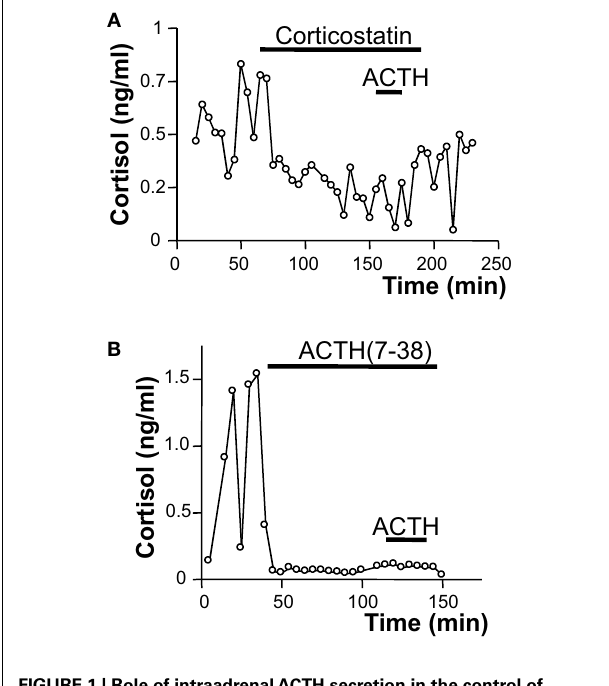
FIGURE 1 | Role of intraadrenalACTH secretion in the control of cortisol production by bilateral macronodular adrenal hyperplasia (BMAH) associated with Cushing’s syndrome . Spontaneous and ACTH-induced cortisol secretions by perifused BMAH explants were inhibited by application of the melanocortin type 2 receptor (MC2R) antagonists corticostatin [2 × 10 − 7 M; (A) ] and corticotropin (7–38) [10 − 7 M; (B) ]. Corticostatin and corticotropin (7–38) significantly reduced the amplitude of cortisol pulses. FIGURE 2 | Catecholaminergic pathway in bilateral macronodular